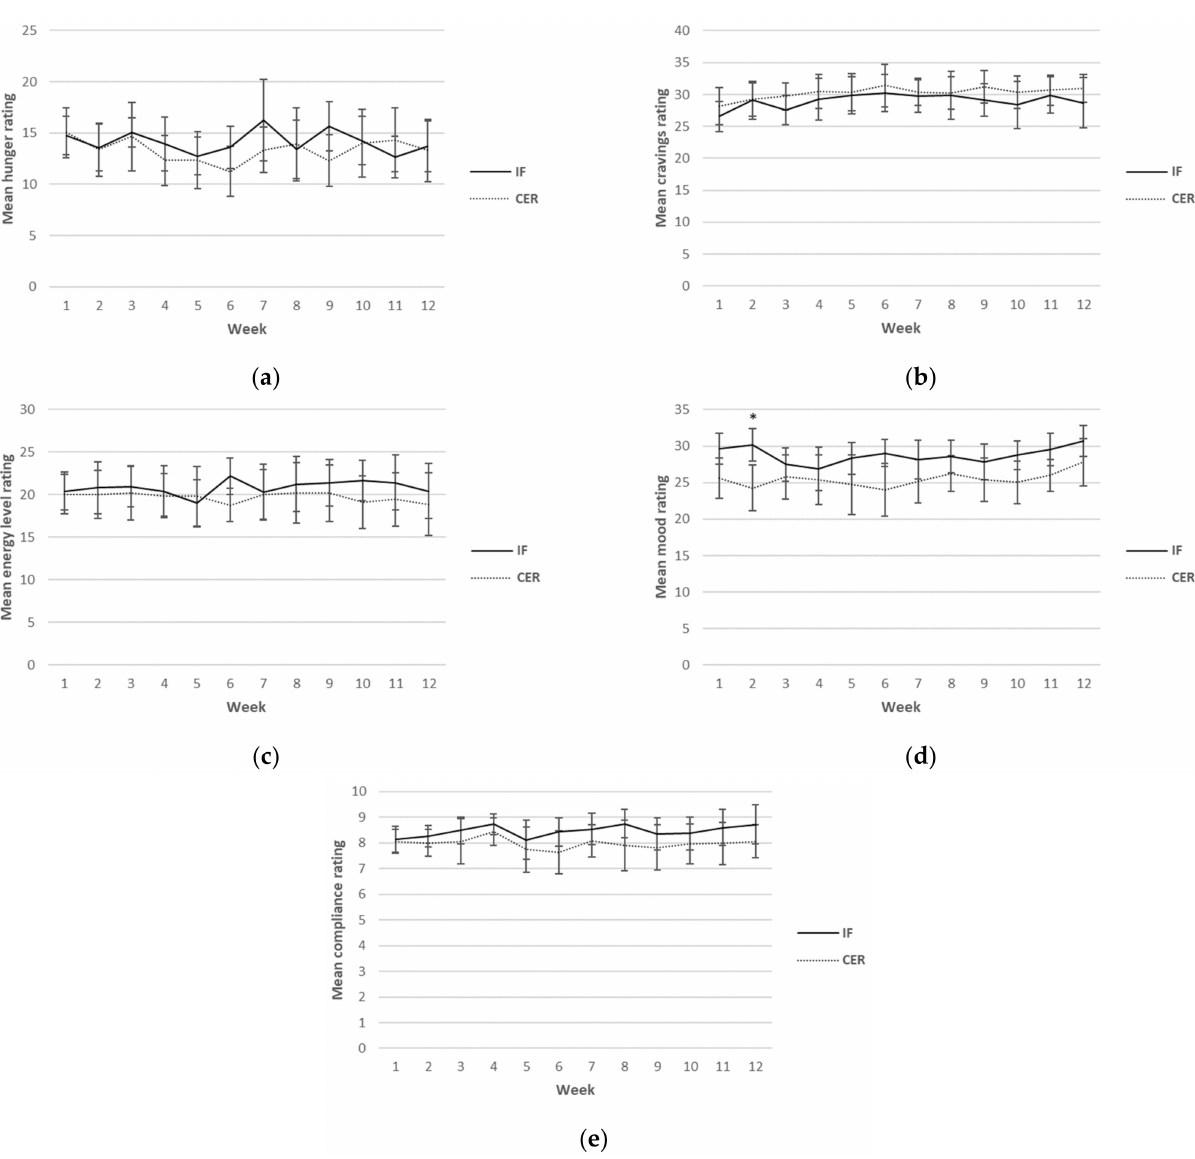
Figure 2. Weekly mean ratings for hunger ( a ), cravings ( b ), energy levels ( c ), mood ( d ) and com- pliance ( e ) over 12 weeks for CERT and IFT participants. IFT = Intermittent Fasting Diet Group, CERT = Continuous Energy Restriction Diet Group. * No overlap in 95% confidence